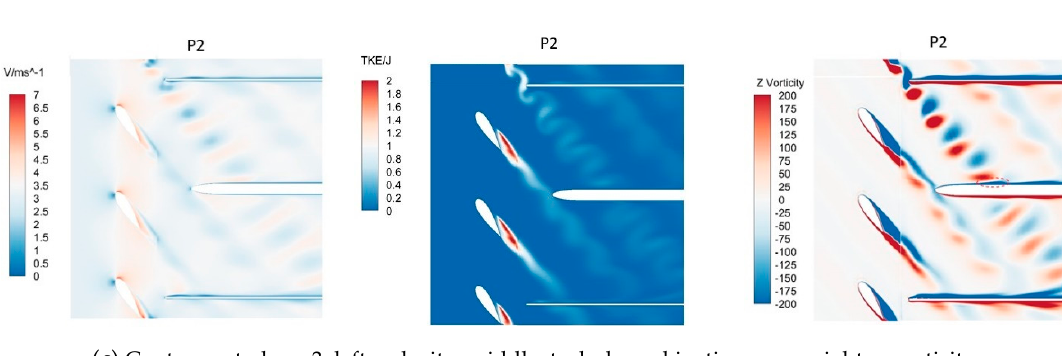
( c ) Contours at phase 3, left: velocity, middle: turbulence kinetic energy, right: z vorticity. Figure 14. Contours of phase-averaged results at three selected phases at f = 40 Hz.